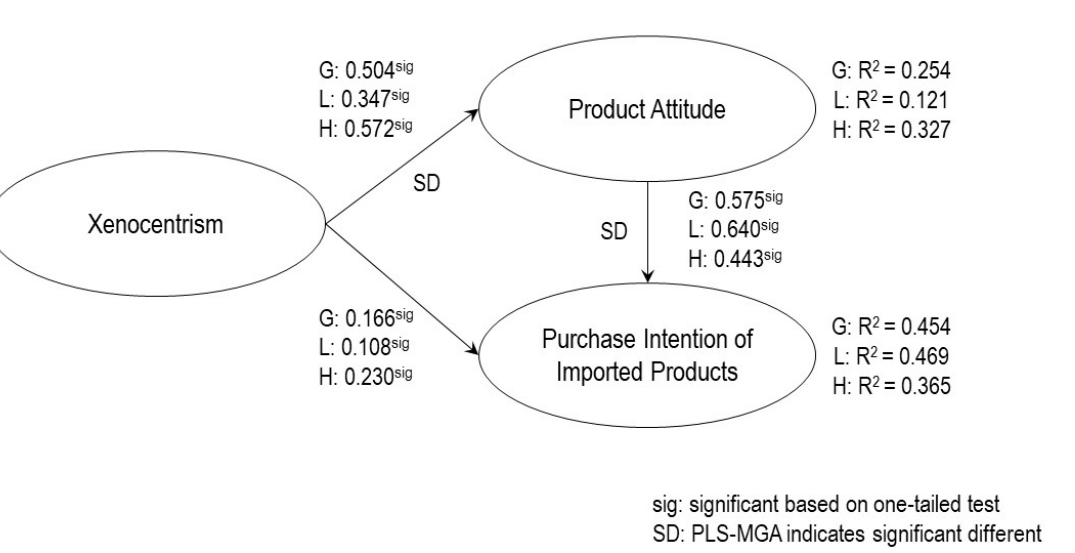
Table 7. Discriminant validity—Heterotrait–Monotrait ratio (HTMT).